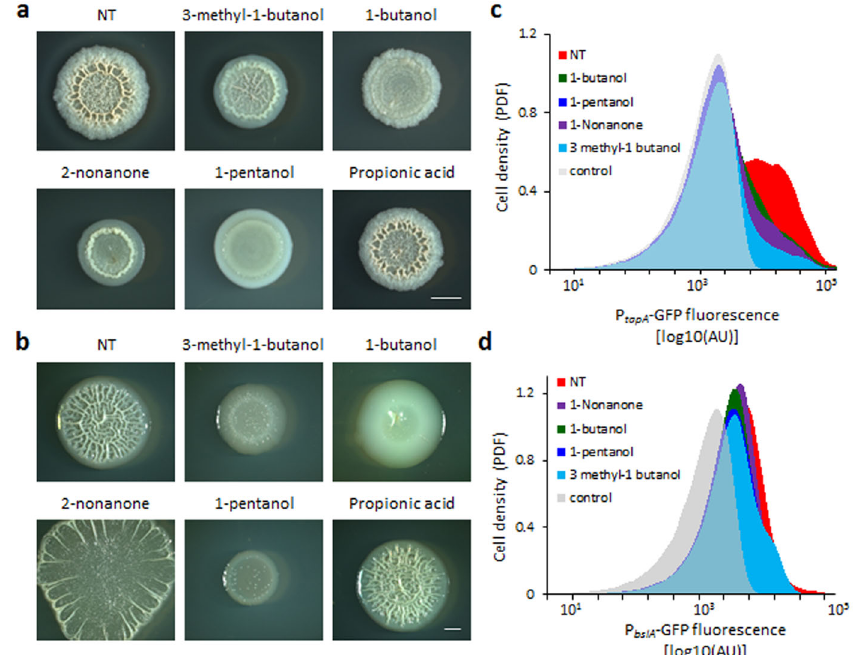
Fig. 5 Structurally related organic VOCs inhibit bio fi lm formation and ECM expression. a B. subtilis 3610 bio fi lm colonies grown on solid B4 medium either alone (NT) or in the presence of the indicated volatiles. The commercial volatiles were added as 3 mL of 0.2% v/v solution placed in a divided agar-plate in Fig. 1b. Colonies were incubated for 2 days at 30 °C. Images are representative of ( n > 3) independent experiments. Scale bar 2 mm. b E. coli bio fi lm colonies grown on solid LBNS medium either alone (NT) or in the presence of indicated commercial volatiles, added as in a . Colonies were incubated for 2 days at 30 °C. Images are representative of ( n > 3) independent experiments. Scale bar 2 mm. c B. subtilis 3610 strains carrying P tapA -GFP or P bslA -GFP were incubated for 2 days either alone (NT) or in the presence of the indicated commercial volatiles. Control (grey) — auto fl uorescence levels of the parental non- fl uorescent strain. Shown are representative results of three independent experiments performed with least two technical